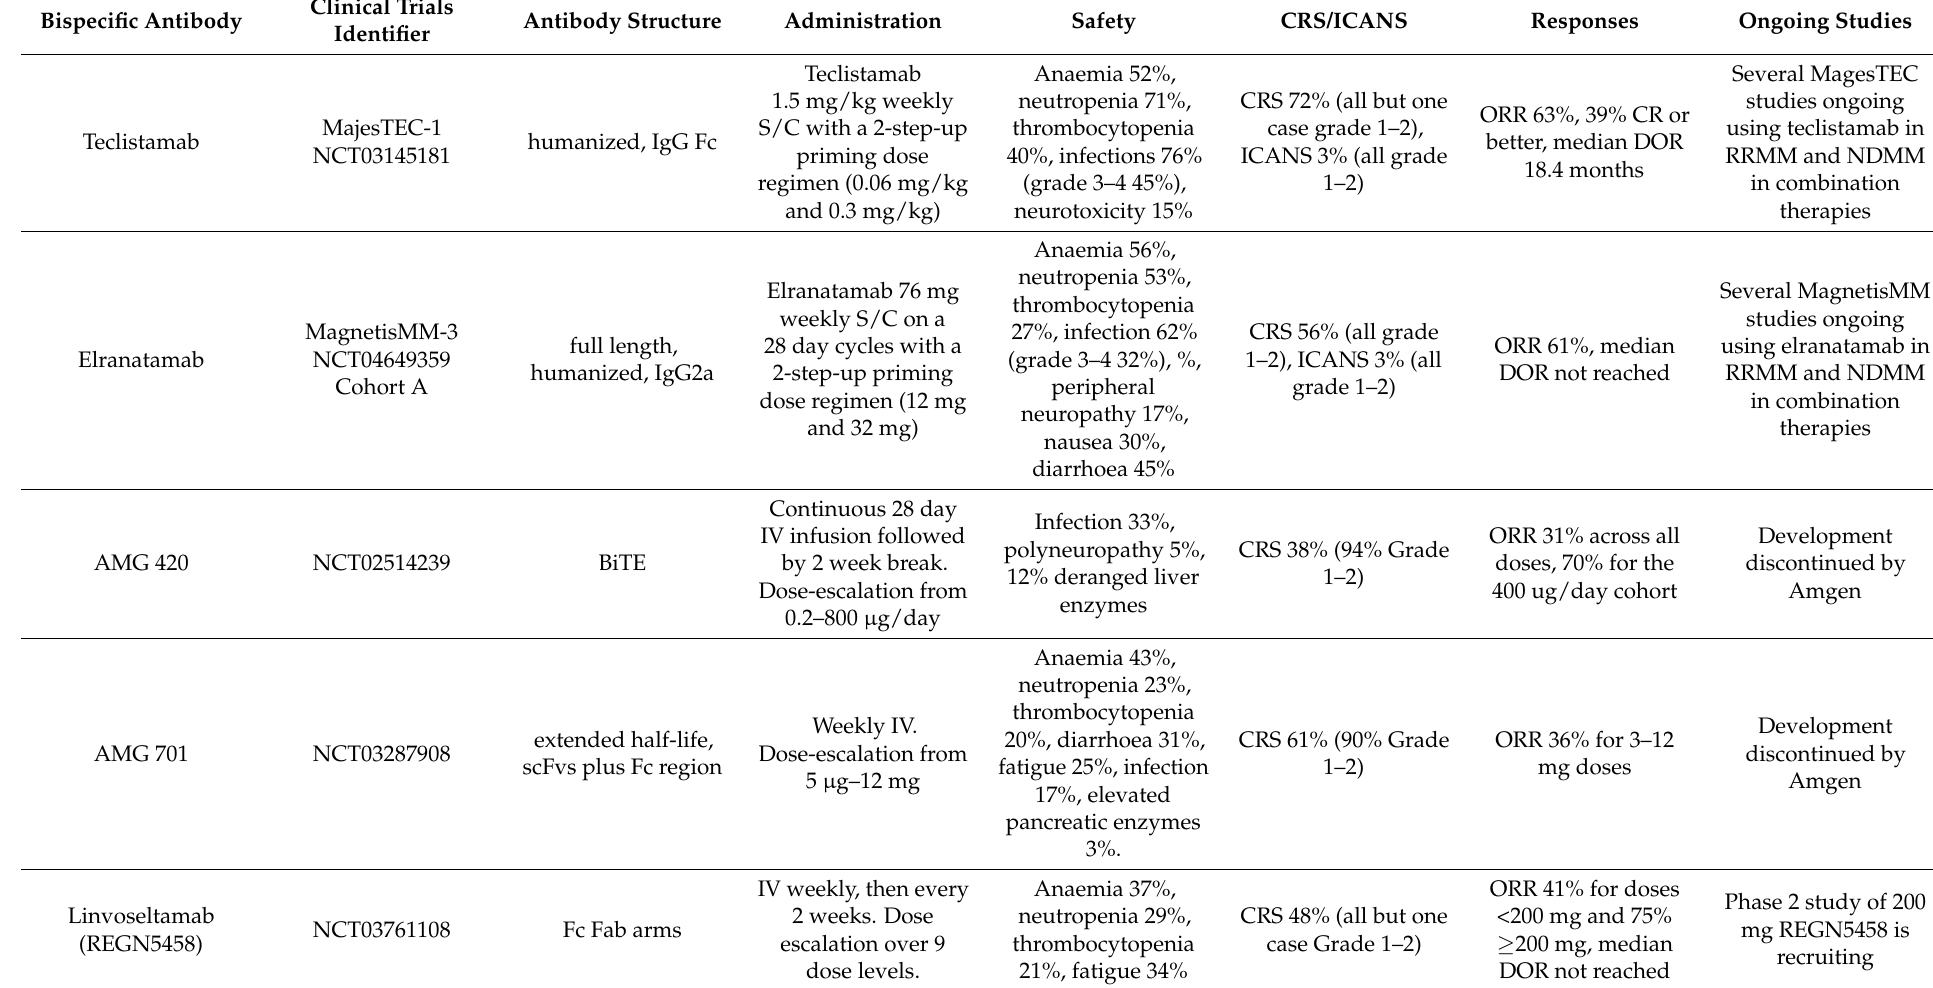
Table 1. Published clinical trials of BCMA BsAbs in